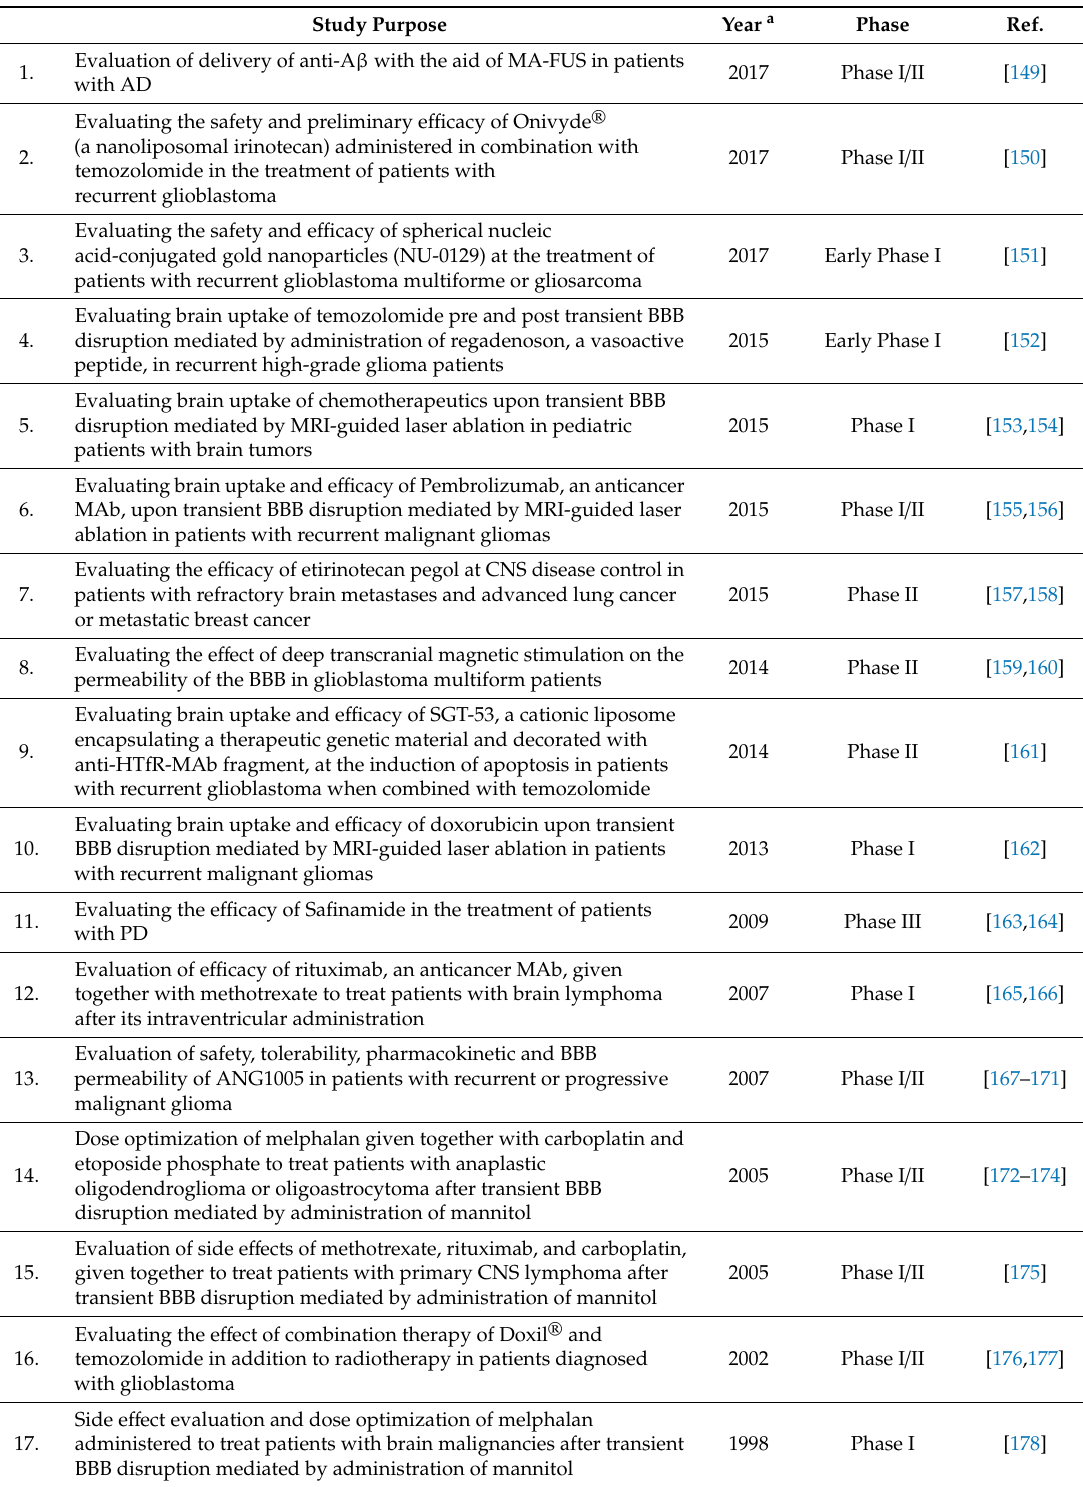
Table 1. Highlights of clinical trial survey showcasing the progress of CNS-drug delivery